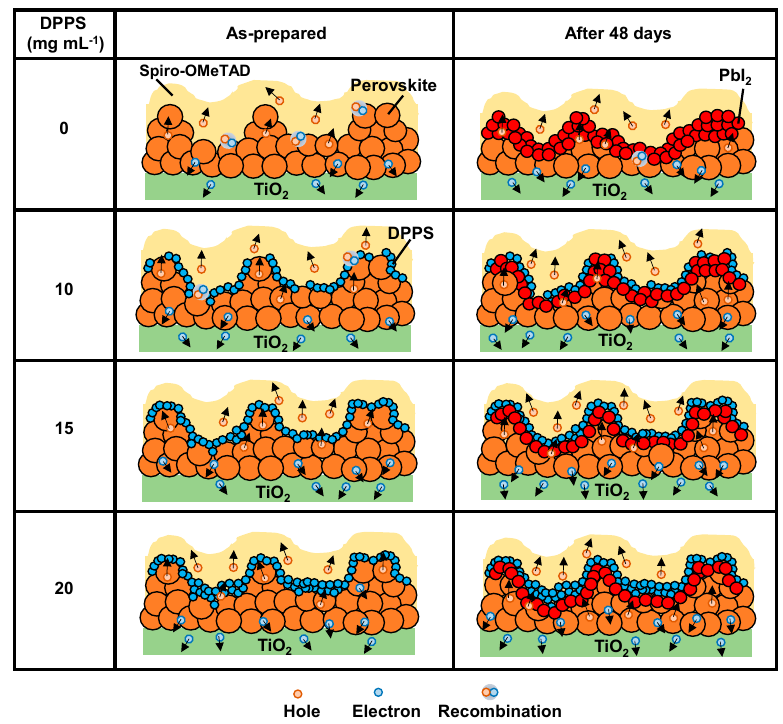
Figure 8. Schematic illustration of the microstructure, carrier dynamics and stability models for perovskite solar cells with different DPPS concentration.